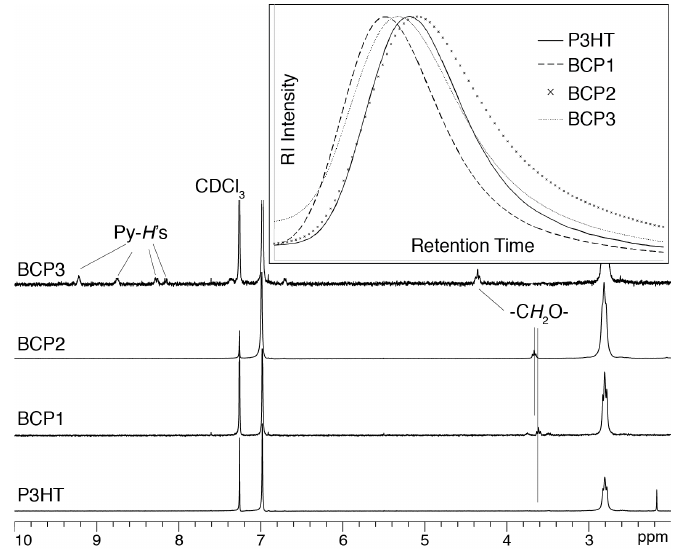
Figure 2. 1 H-NMR overlay of P3HT, BCP1, BCP2 and BCP3 in selected regions. Insert: size exclusion chromatograms (SEC) of the same polymers (RI, CHCl 3 , 1 mL/min).